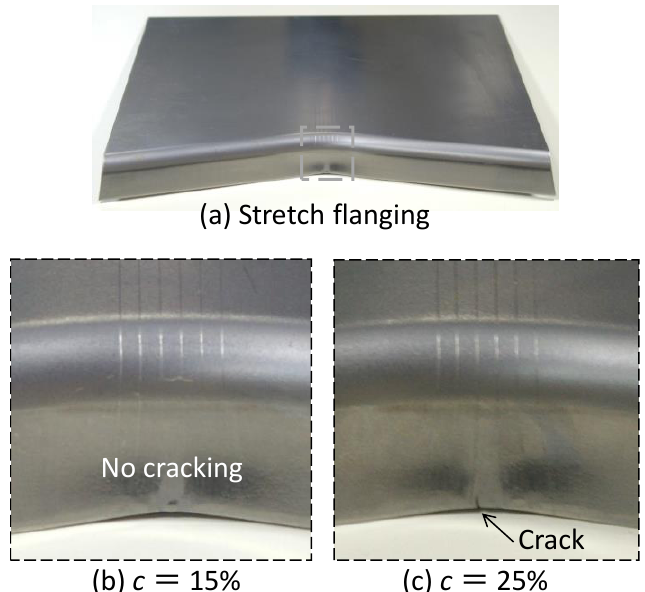
Figure 3. Effect of clearance ratio on cracking in stretch flanging ( a ) of 780 MPa dual phase steel sheet for ( b ) c = 15% ( c ) c = 25%.